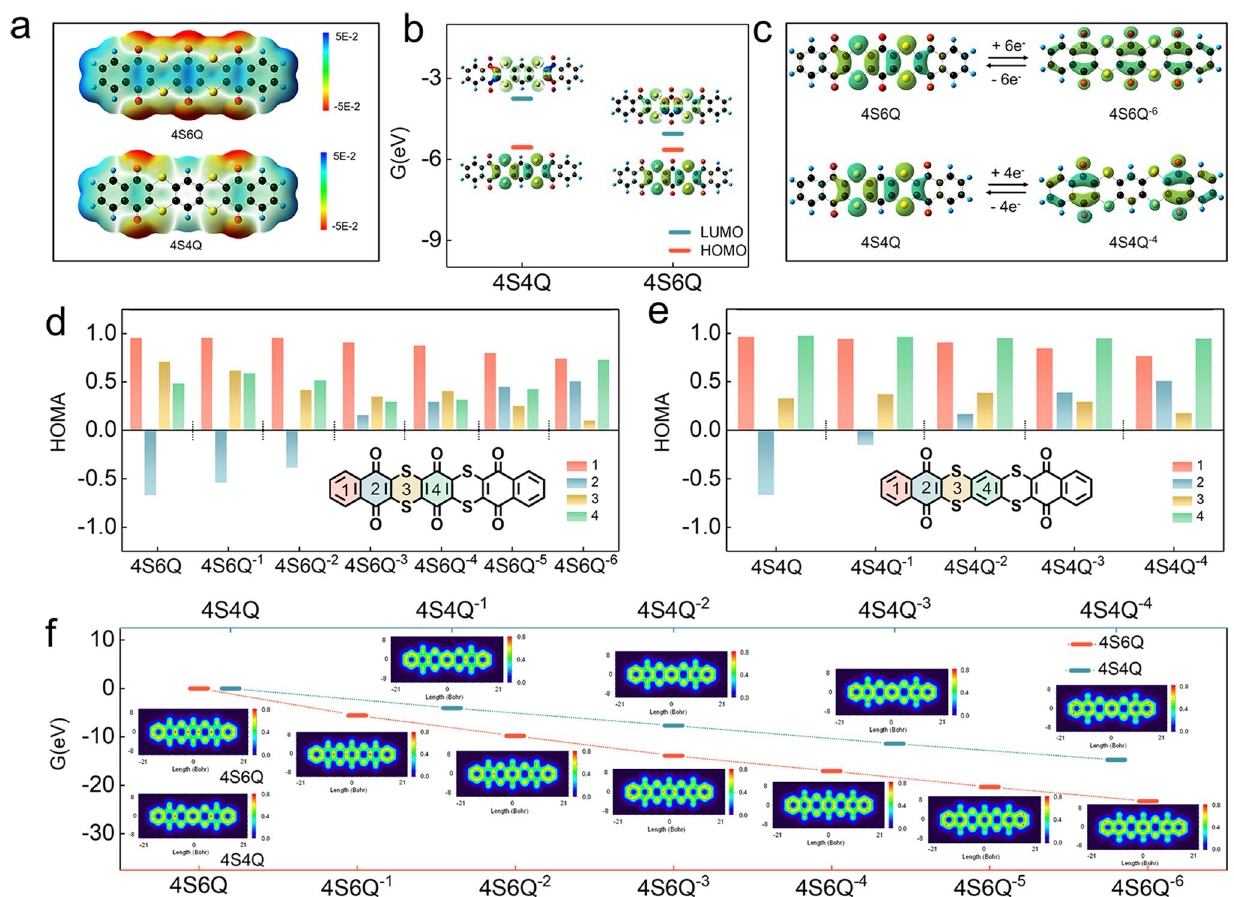
Fig. 2 DFT calculations. a The MESP image of 4S4Q and 4S6Q molecules. b Calculated LUMO and HOMO plots of 4S4Q and 4S6Q mol- ecules. c Calculated HOMO plots of 4S4Q, 4S4Q 4− , 4S6Q, and 4S6Q. 6− molecules. d Calculated HOMA values of 4S6Q and corresponded reduction states. e Calculated HOMA values of 4S4Q and corresponded reduction states. f Energy level of neutral and reduced 4S6Q and 4S4Q molecules (the inserted images reflect the simulative